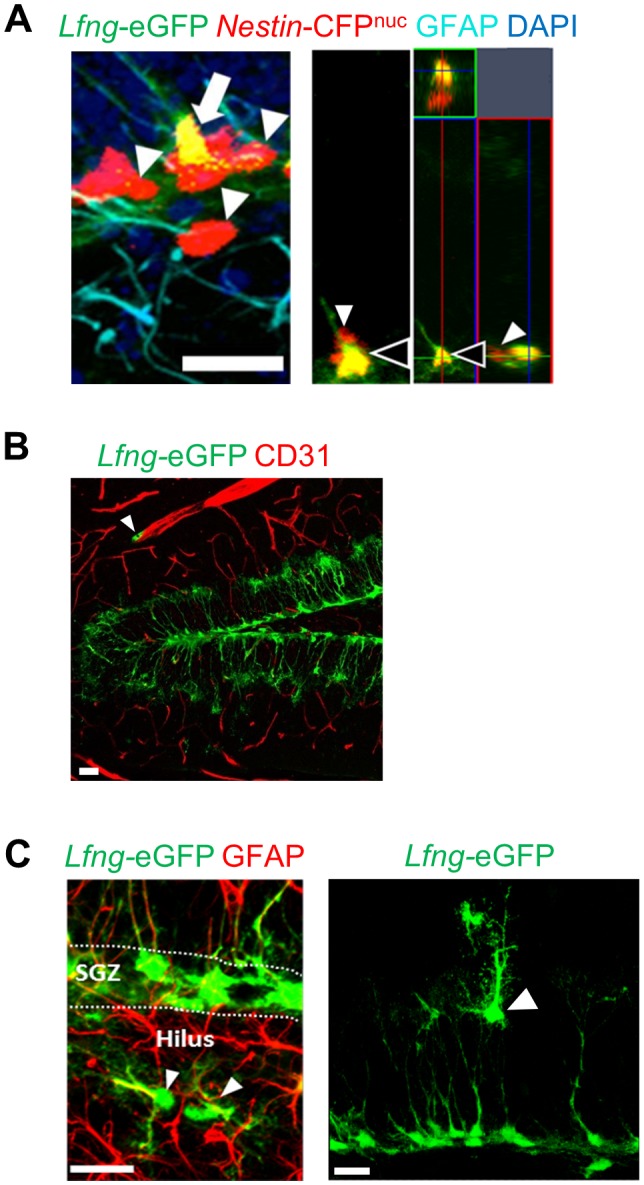
Lfng-eGFP labels a small number of non-NSC cell types in the dentate gyrus. (A) In a double transgenic Lfng-eGFP; Nestin-CFPnuc mouse, NSCs express both CFP and eGFP, and have a radial GFAP+ process (arrow). Those that express only CFP have round morphology with no processes and are presumed ANPs (arrowheads). Orthogonal projection shows a NSC expressing both Lfng-eGFP and Nestin-CFPnuc (black arrowhead) and a neighboring ANP expressing only Nestin-CFPnuc (white arrowhead). Scale bar = 20 µm. (B) Lfng-eGFP is expressed in tip-like cells in close proximity to the endothelial cells immunolabeled with CD31 (arrowhead). Scale bar = 20 µm. (C) Random unidentified Lfng-eGFP+ cells are detected in the hilus (left panel; arrowhead) and molecular layer (right panel; arrowhead). Scale bar = 20 µm.